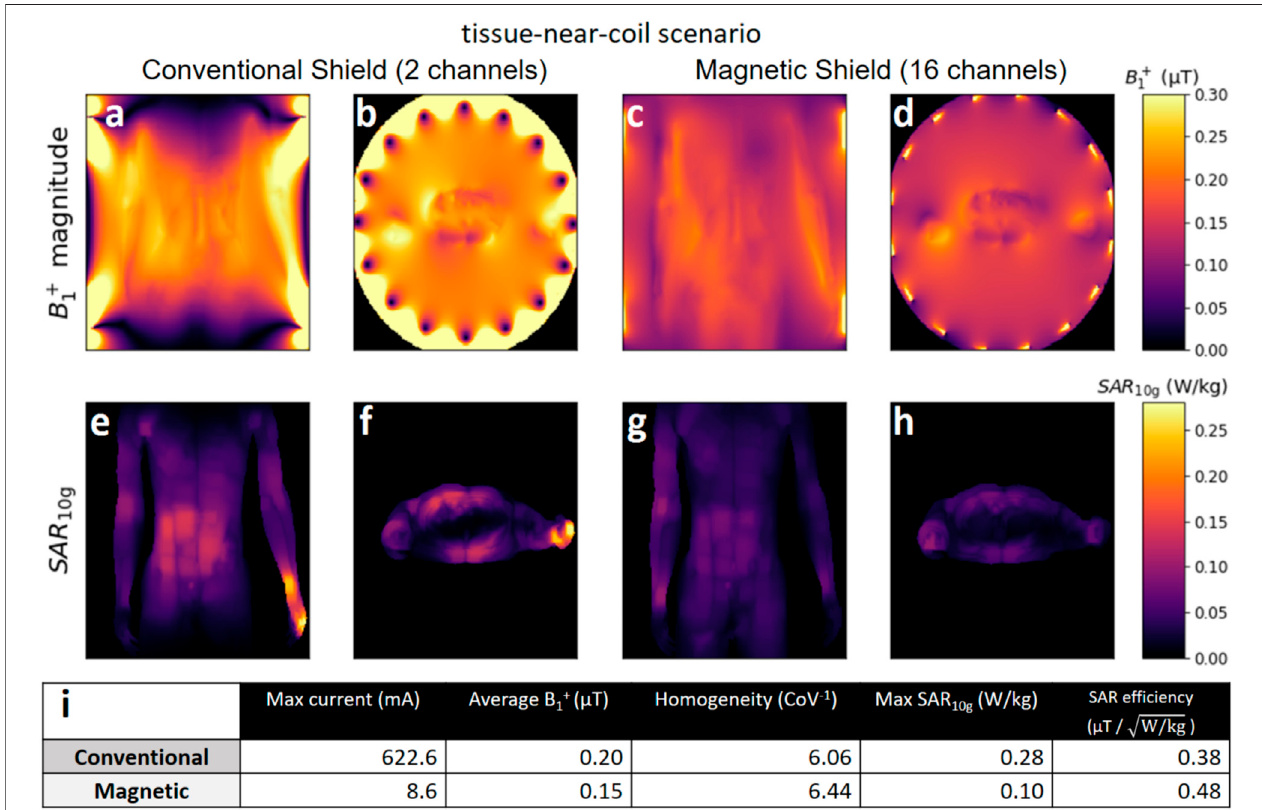
FIGURE 13 | Same as Figure 12 , except for the fact that the model now has his hand close ( ∼ 8 mm) to one of the endrings. Field distribution in the birdcage coils with conventional [PEC, (A,B,E,F) ] and magnetic [PMC, (C,D,G,H) ] shield. The top row shows coronal (A,C) and transverse (B,D) slices of the B 1+ distribution. The bottom row shows maximum intensity projections of the 10-g averaged local SAR distributions projected to the coronal (E,G) and transverse (F,H) plane. The table (I) summarizes important metrics calculated from the fi elds. Maximum current values are found in the endrings of the PEC-birdcage but in the rungs of the PMC- birdcage. All fi elds are normalized to 1 W of accepted